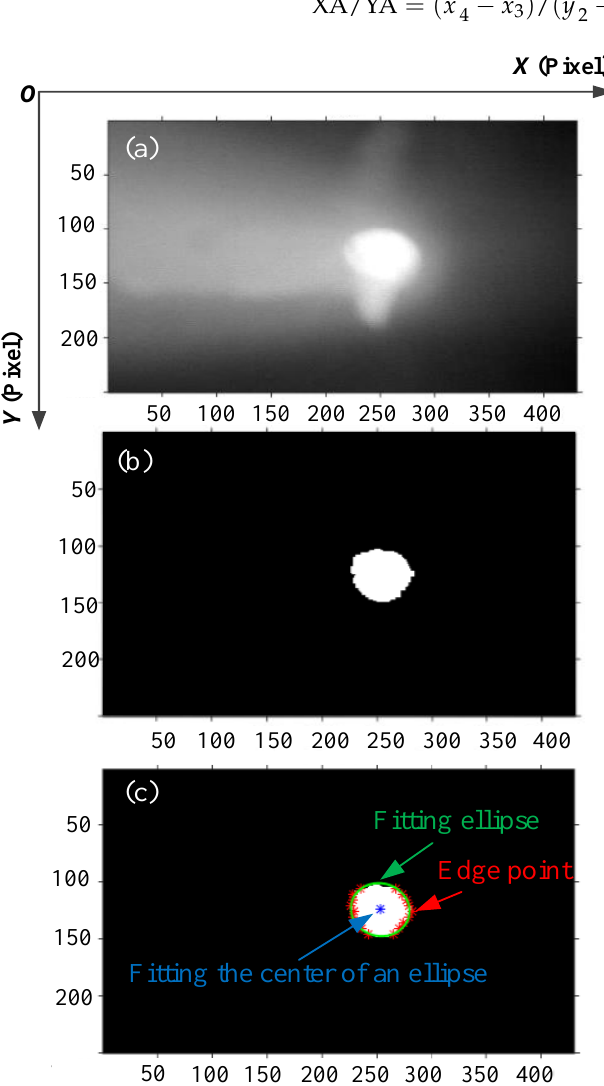
Figure 3. Keyhole edge extraction effect diagram: ( a ) raw image; ( b ) two-level threshold segmentation; ( c ) elliptical curves fitting.